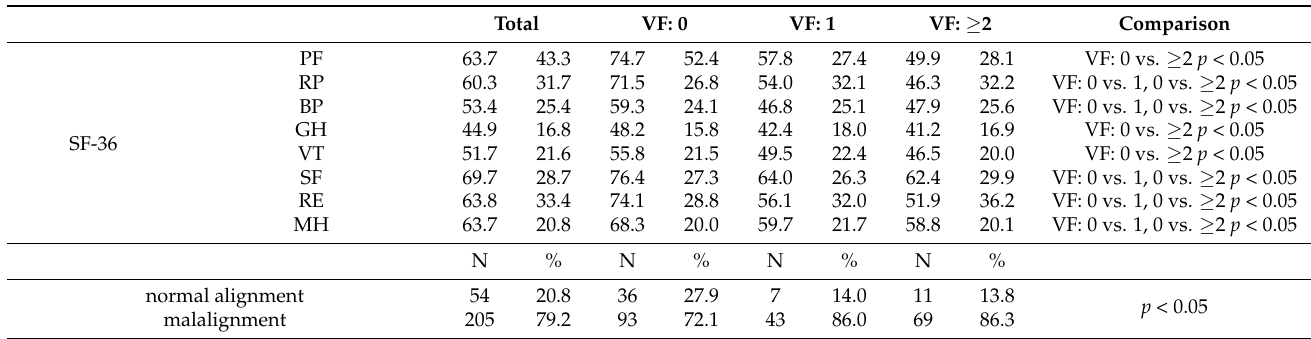
Figure 2. In patients without VFs, comparisons of ( A ) JOABPEQ, ( B ) ODI, and ( C ) VAS of LBP for patients of the normal alignment and sagittal malalignment groups are shown. VF, vertebral fracture; LBP, low back pain; ODI, Oswestry Disa- bility Index; JOABPEQ, Japanese Orthopedic Association Back Pain Evaluation Questionnaire; VAS, Visual Analogue Scale, * p < 0.05.